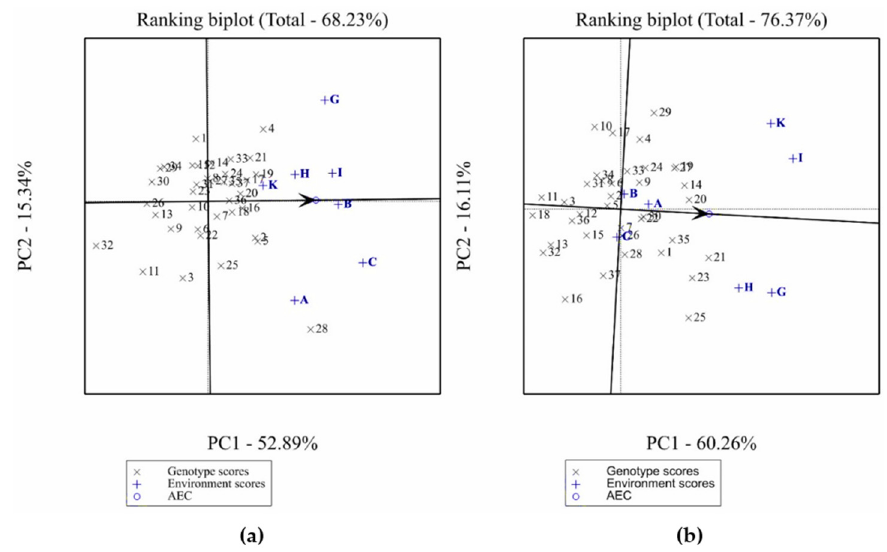
Figure 4. Ranking plot of the GGE showing the performance and stability of the faba bean genotypes for plant height ( a ) and seed yield ( b ) .